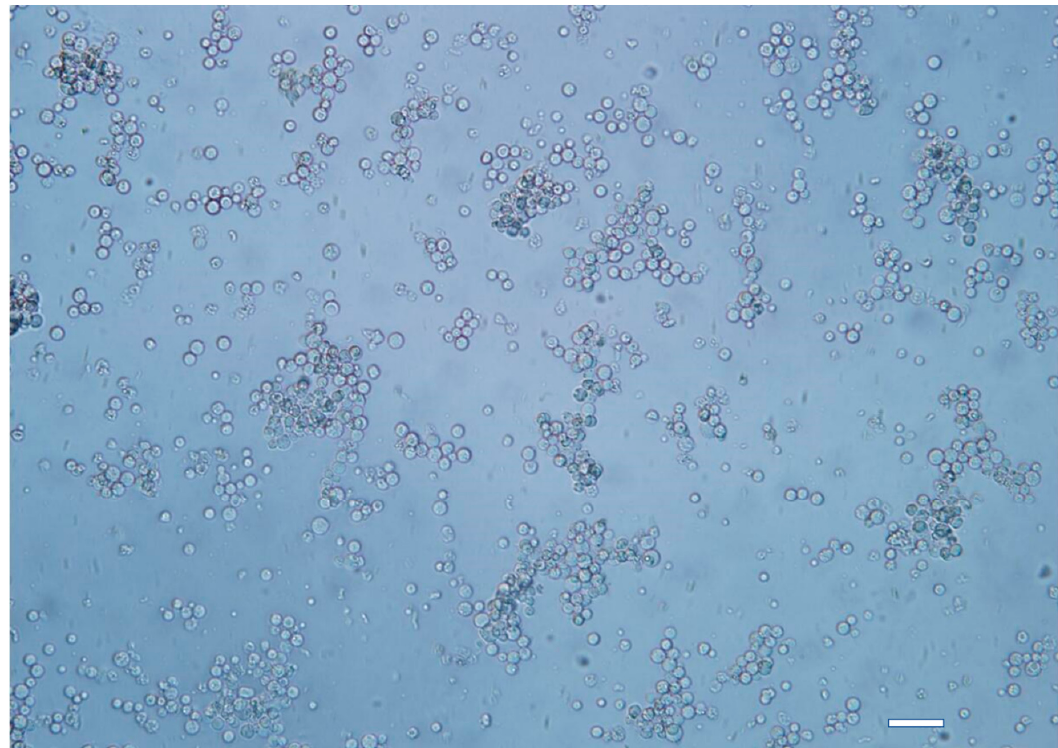
Figure 2. The mycelia were digested in protoplast release buffer 2 at 31 °C with shaking for 1.5 h. Sufficient protoplasts formed thereafter, with concentrations reaching 3.0 × 10 9 spores mL − 1 . Bar: 100 μ